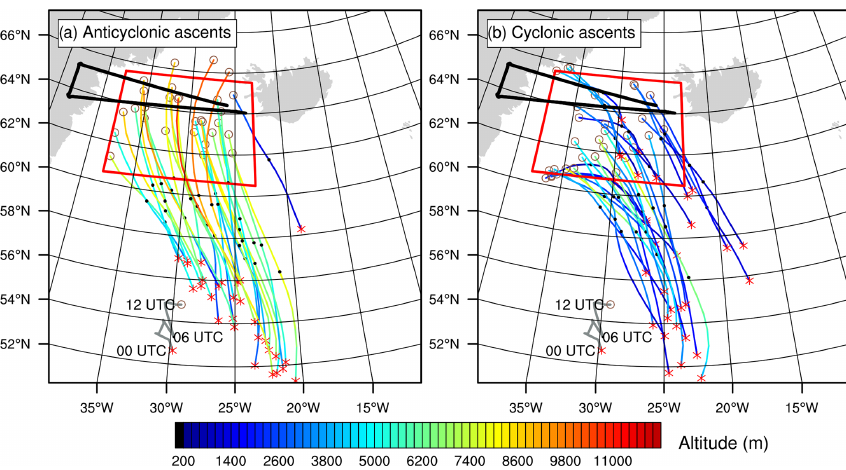
Figure 6. Selected trajectories colored by altitude, between 00:00 and 12:00UTC, for (a) anticyclonic ascents and (b) cyclonic ascents simulated by REF. Only 30 trajectories (out of 220000 anticyclonic ascents and out of 250000 cyclonic ascents) are plotted for each category of ascents. A red cross, a black dot and a brown circle show the location of each trajectory at 00:00, 06:00 and 12:00UTC, respectively. The black line shows the track of the Falcon 20 aircraft, the gray line the position of the MSLP minimum and the red box the region where the ascents are selected at 11:00UTC.